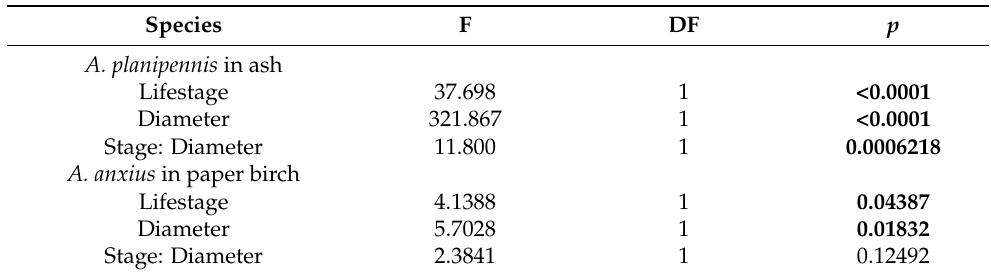
Table 4. Statistical values from the models for the gallery depths of A. planipennis and A. anxius. p values considered significant (<0.05) are shown in bold.